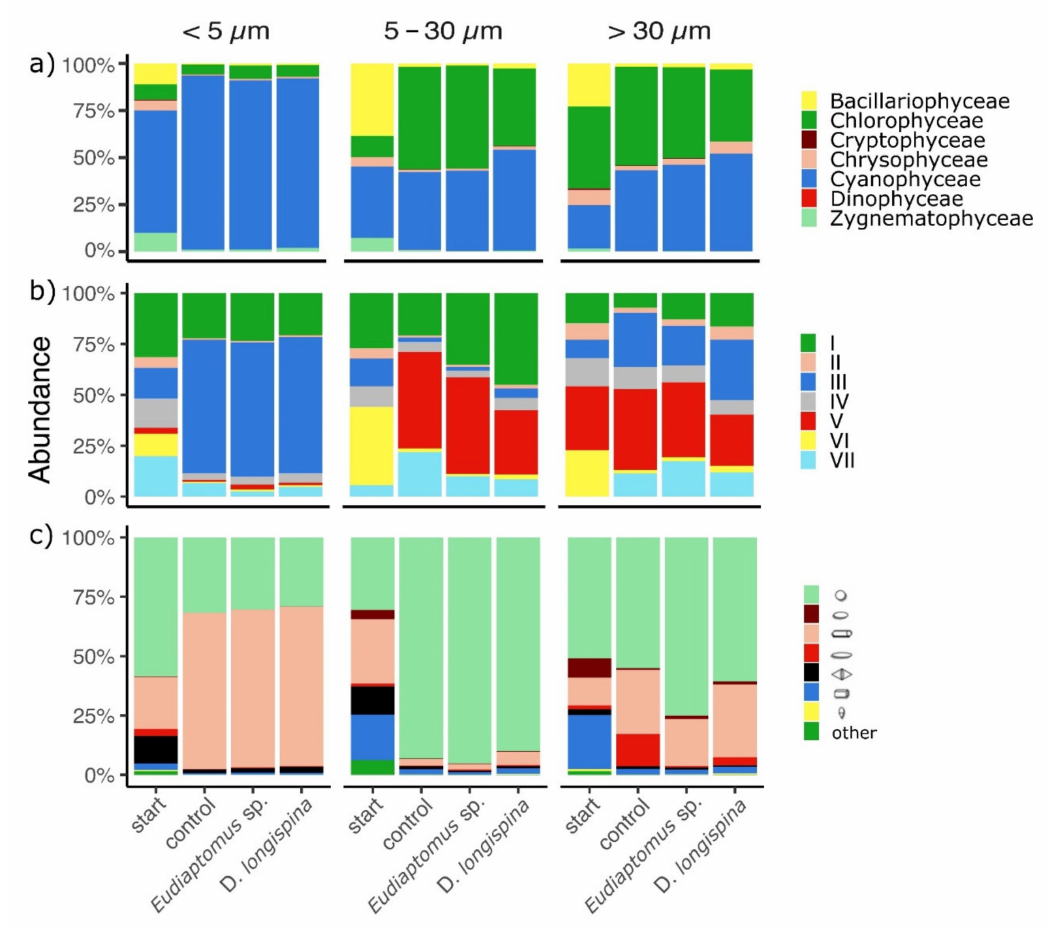
Figure 2. Mean relative abundance (%) of phytoplankton ( a ) taxonomic groups ( b ) morpho-functional groups and ( c ) shapes for each of the three size fractions and the starting condition, the control and grazed treatments. Morpho-functional groups are: (I) small organisms with high surface/volume (II) small flagellated organisms with siliceous exoskeletal structure (III) large filaments (with aerotopes), (IV) organisms of medium size lacking specialized traits (V) unicellular flagellates of medium to large size (VI) non-flagellated organisms with siliceous exoskeletons and (VII) large mucilaginous colonies. In 2c, the eight dominant shapes are: spheres (light green), prolate spheroids (brown), cylinders (pink), ellipsoids (red), double cons (black), prisms (blue), cones with half sphere (yellow) and others (green) among the three size classes and between the starting conditions and the control and grazed